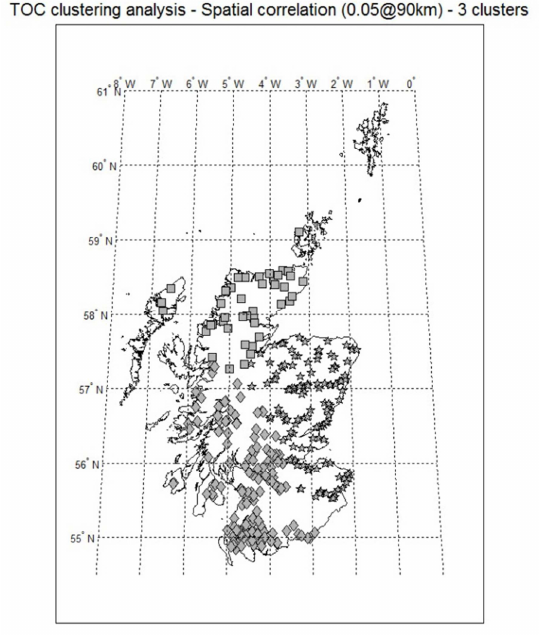
Figure 5 – Clustering for Scottish rivers based on dynamic factor analysis (Finazzi et al. ,